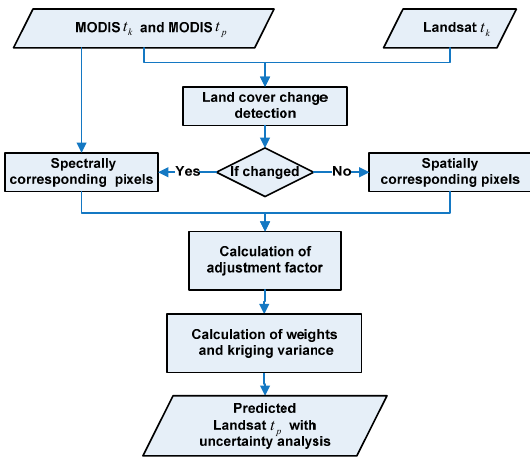
Figure 1. Flowchart of the rigorously-weighted spatiotemporal fusion model (RWSTFM) for blending Landsat and MODIS imagery.